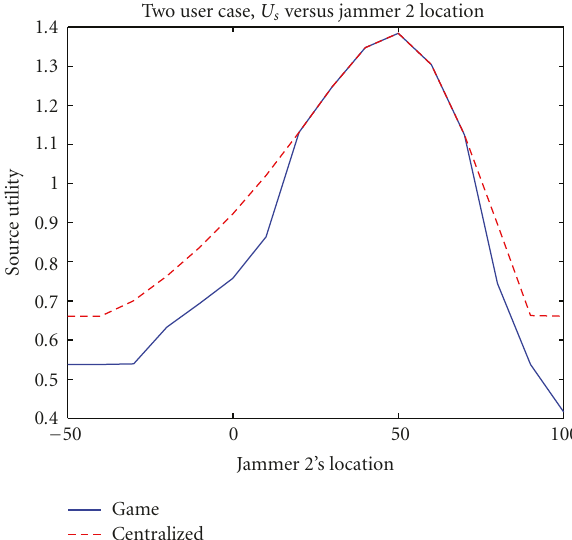
Figure 7: U s versus the location of the second